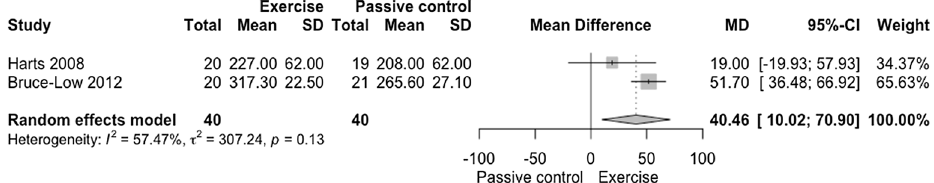
Figure 5. Forest plot of the comparison of exercise vs. passive control on trunk extensor strength. Harts (2008) 41 : Low-intensity training-LIT versus No intervention—Modified lower back machine (Newton meter). Bruce-Low et al. (2012) 37 : Exercise versus No intervention—Lumbar extension machine, Dynamometer (Newton